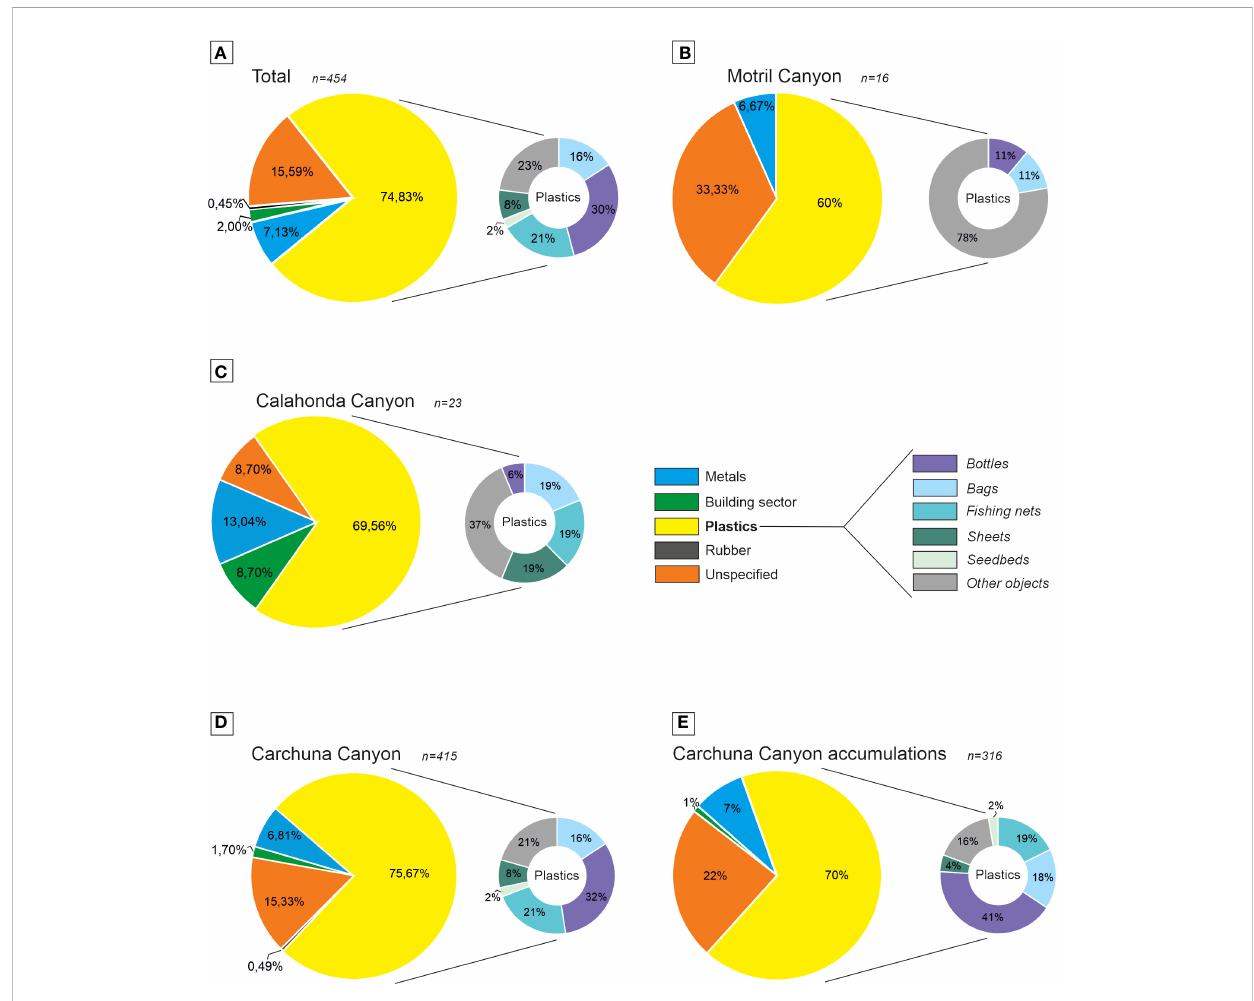
FIGURE 3 Litter composition in the three studied submarine canyons. Percentages of litter items are divided into fi ve litter categories and six plastic subcategories as de fi ned by the Guidance on Monitoring of the Marine Litter in the Mediterranean Sea (European Commission of the European Union, 2013): (A) studied submarine canyons; (B) upper segment of Motril Canyon; (C) upper segment of Calahonda Canyon; (D) Carchuna Canyon; and (E) Carchuna Canyon accumulations. n: total number of litter items